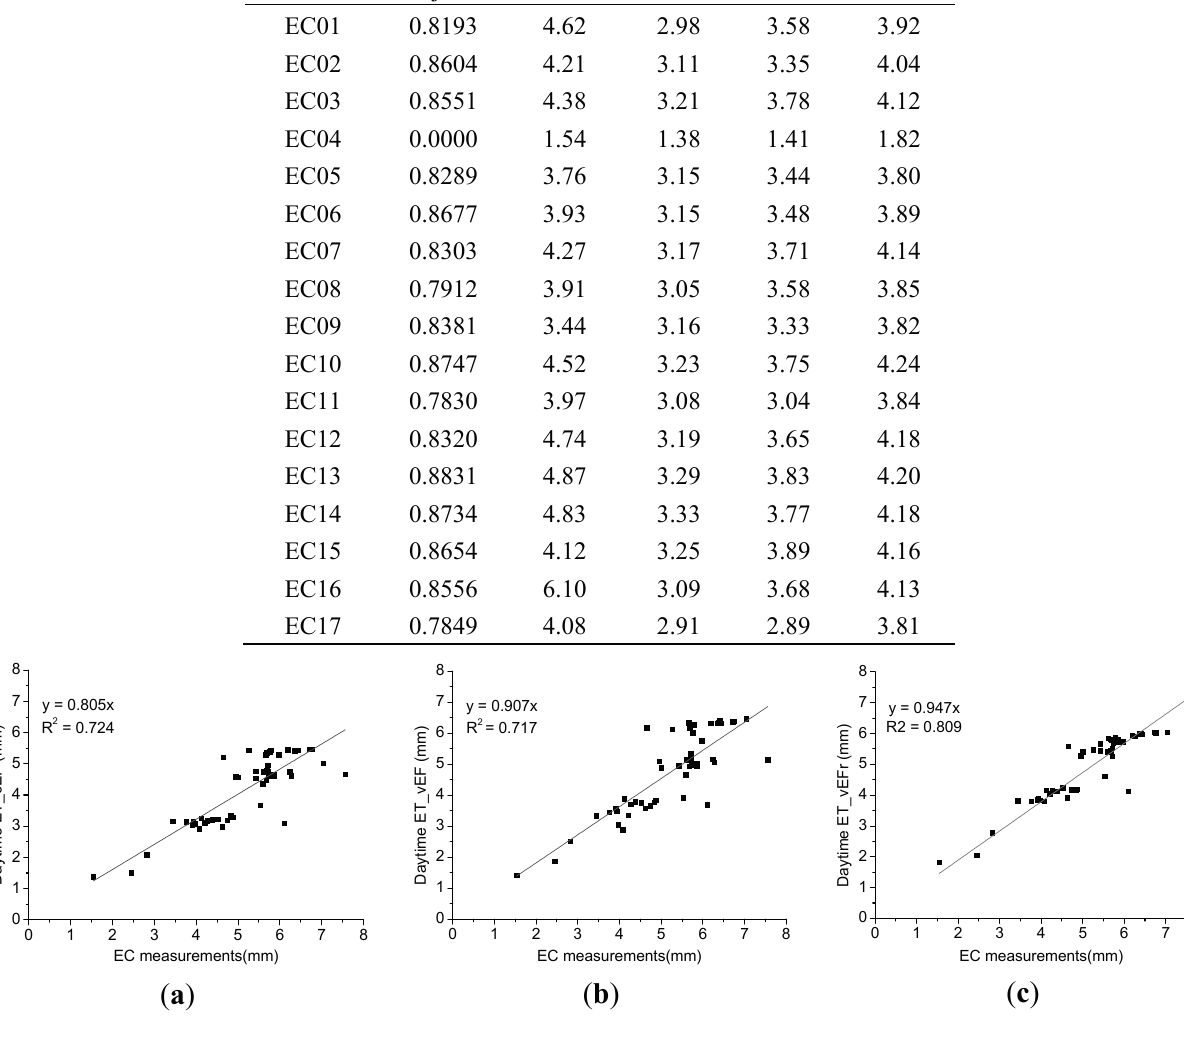
Figure 7. Comparison of the EC measurements and ET dt based on the estimates from the ( a ) cEF, ( b ) vEF and ( c ) vEFr methods. Table 7. Validation statistics for the three ET temporal scaling